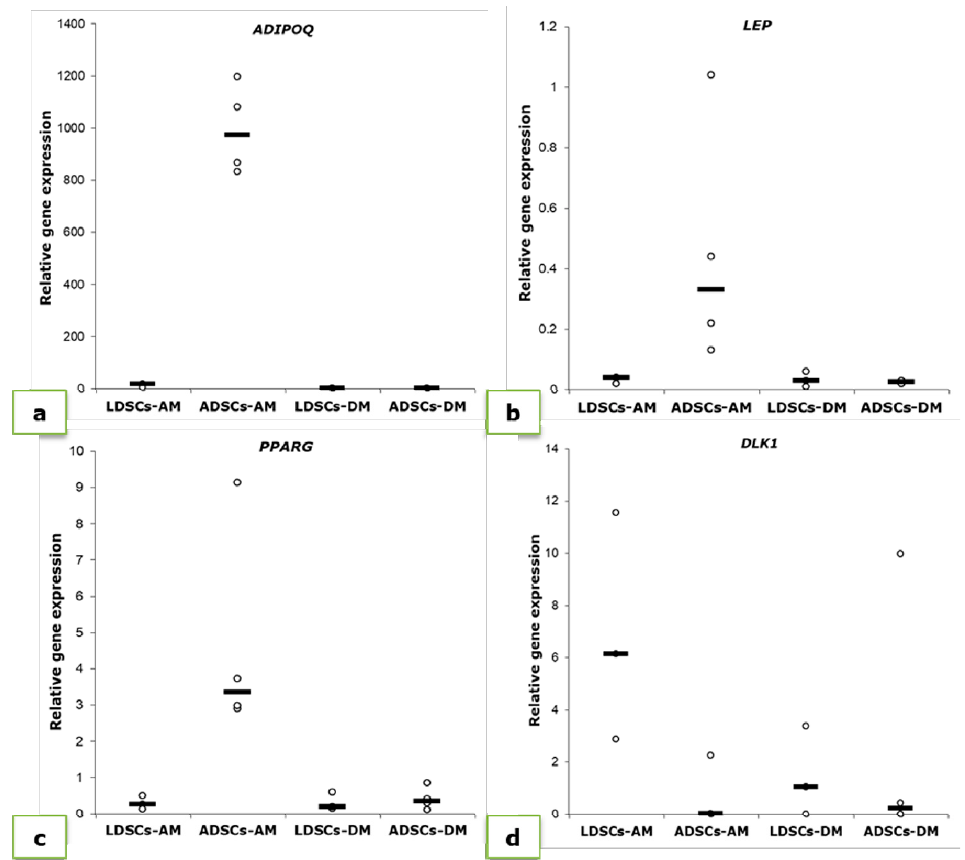
Figure 8. Relative expression levels (2 - ∆∆ Ct ) of genes for adiponectin ( ADIPOQ ) ( a ), leptin ( LEP ) ( b ), PPAR-gamma ( PPARG ) ( c ) and Pref-1 ( DLK1 ) ( d ), measured in LDSCs and ADSCs at day 21 of adipogenic differentiation and normalized to GAPDH ; scatterplots with median; n = 4 for all groups and genes. Table 1. Relative expression of ADIPOQ , LEP , PPARG and DLK1 in LDSCs and ADSCs at day 21 of adipogenic differentiation, normalized to GAPDH and compared to the cells at P2 (day 0). Results are expressed as mean values ± SD. Asterisks represent statistical significance compared to P2 (day 0).